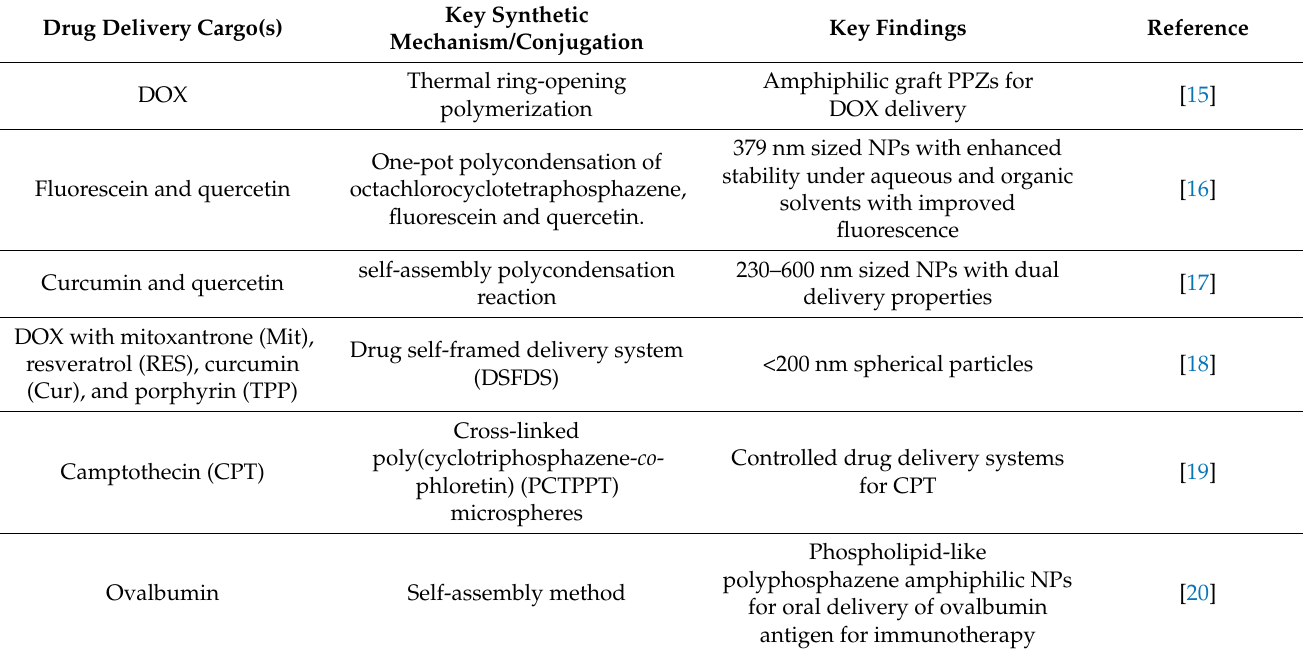
Table 1. Recently reported various polyphosphazene-based various drug delivery